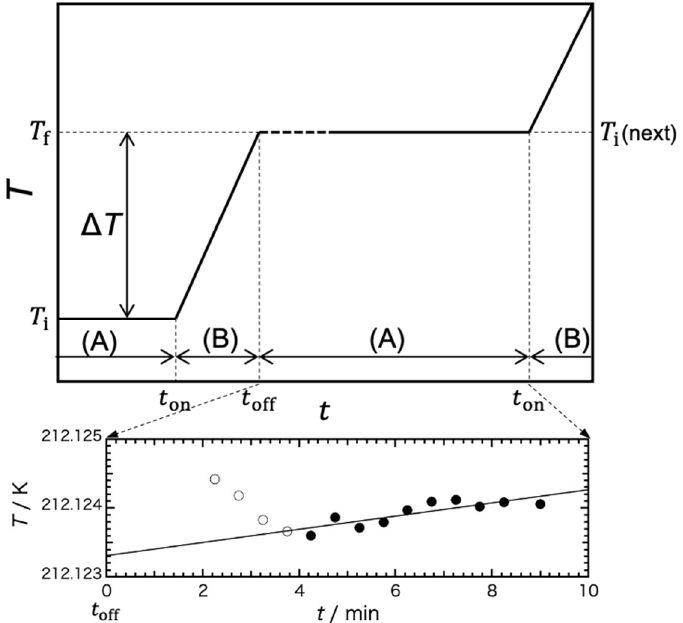
Figure 10. Schematic diagram of the temperature change of the sample with time during the heat- capacity measurement by using an adiabatic calorimeter (upper) and an example of the data of the temperature measurement (lower). The measurements were performed by the intermittent-heating method, repetition of an equilibration period (A) and a heating period (B). In the equilibration period (A), the dashed and solid lines represent thermal equilibration time and temperature measuring time, respectively.